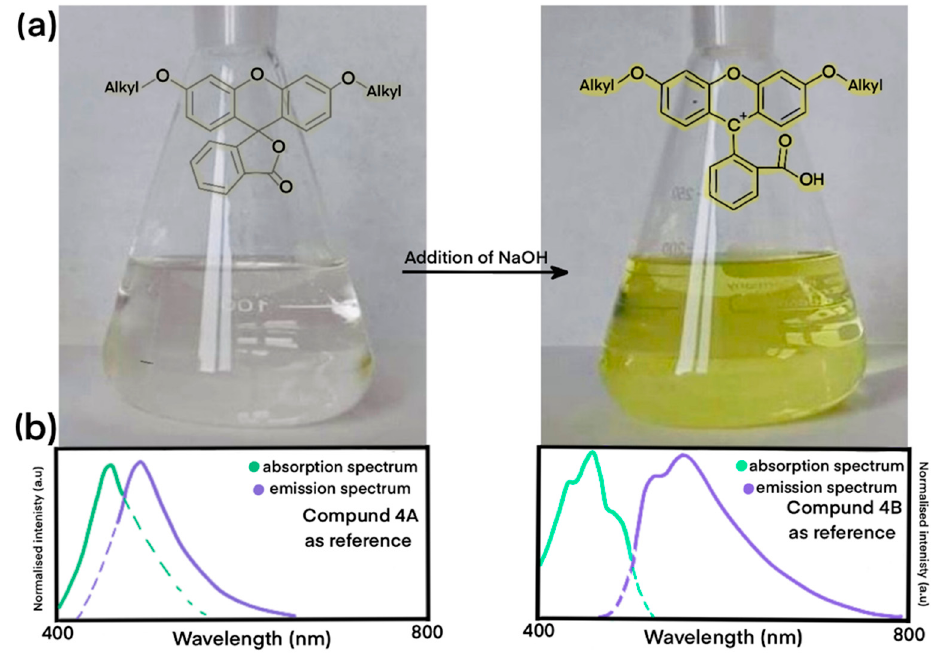
Figure 4. ( a ) Changes in color of solution of compounds A after adding NaOH with probable chemical formula for both forms (before and after addition of base); ( b ) Emission and absorption spectra of compounds 4A , 4B as references.